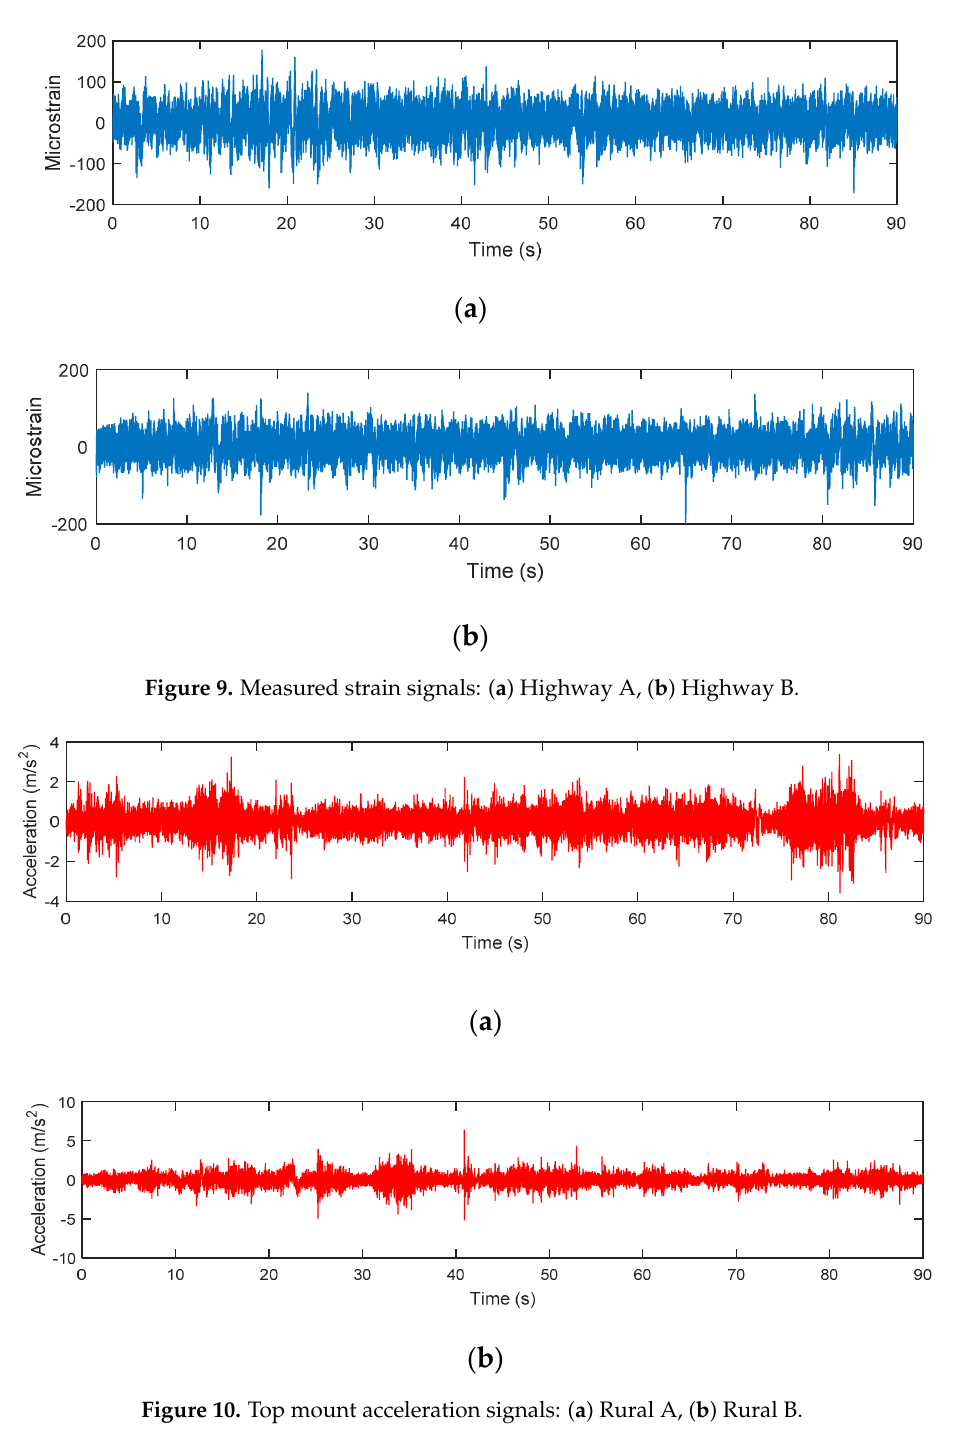
Figure 10. Top mount acceleration signals: ( a ) Rural A, ( b ) Rural B.